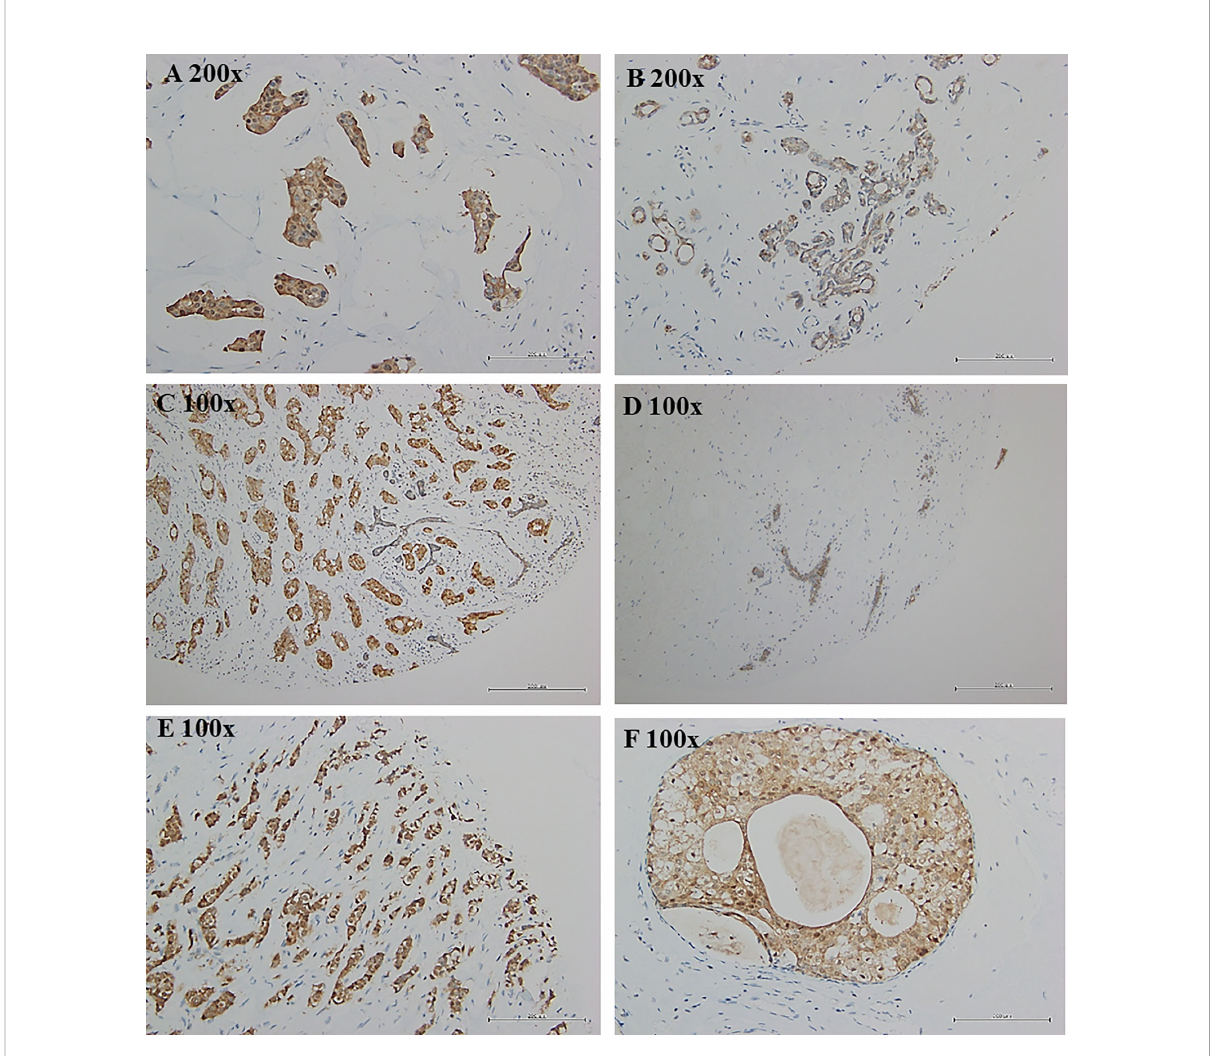
FIGURE 3 Protein expression of tstd1 in breast tissues. (A) tumor tissues; (B, D) normal/lobular tissues; (C, E) invasive tumor tissues; (F) carcinoma in situ tissues. Immunohistochemistry staining results were captured by microscope. Images in the same row were taken from same patient. (A, B) patient sh078; (C, D) patient sh085; (E, F) patient sh095. Original magni fi cation is as shown in each